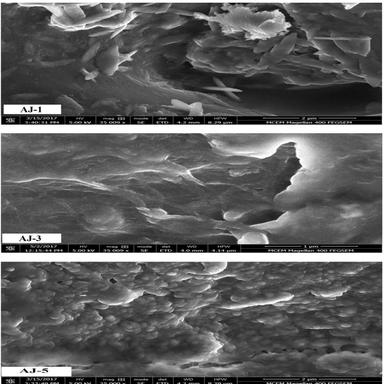
SEM Images of Chitosan based PU (AJ-1), Chitosan/starch blends based PU (AJ-3) and starch based PU (AJ-5).